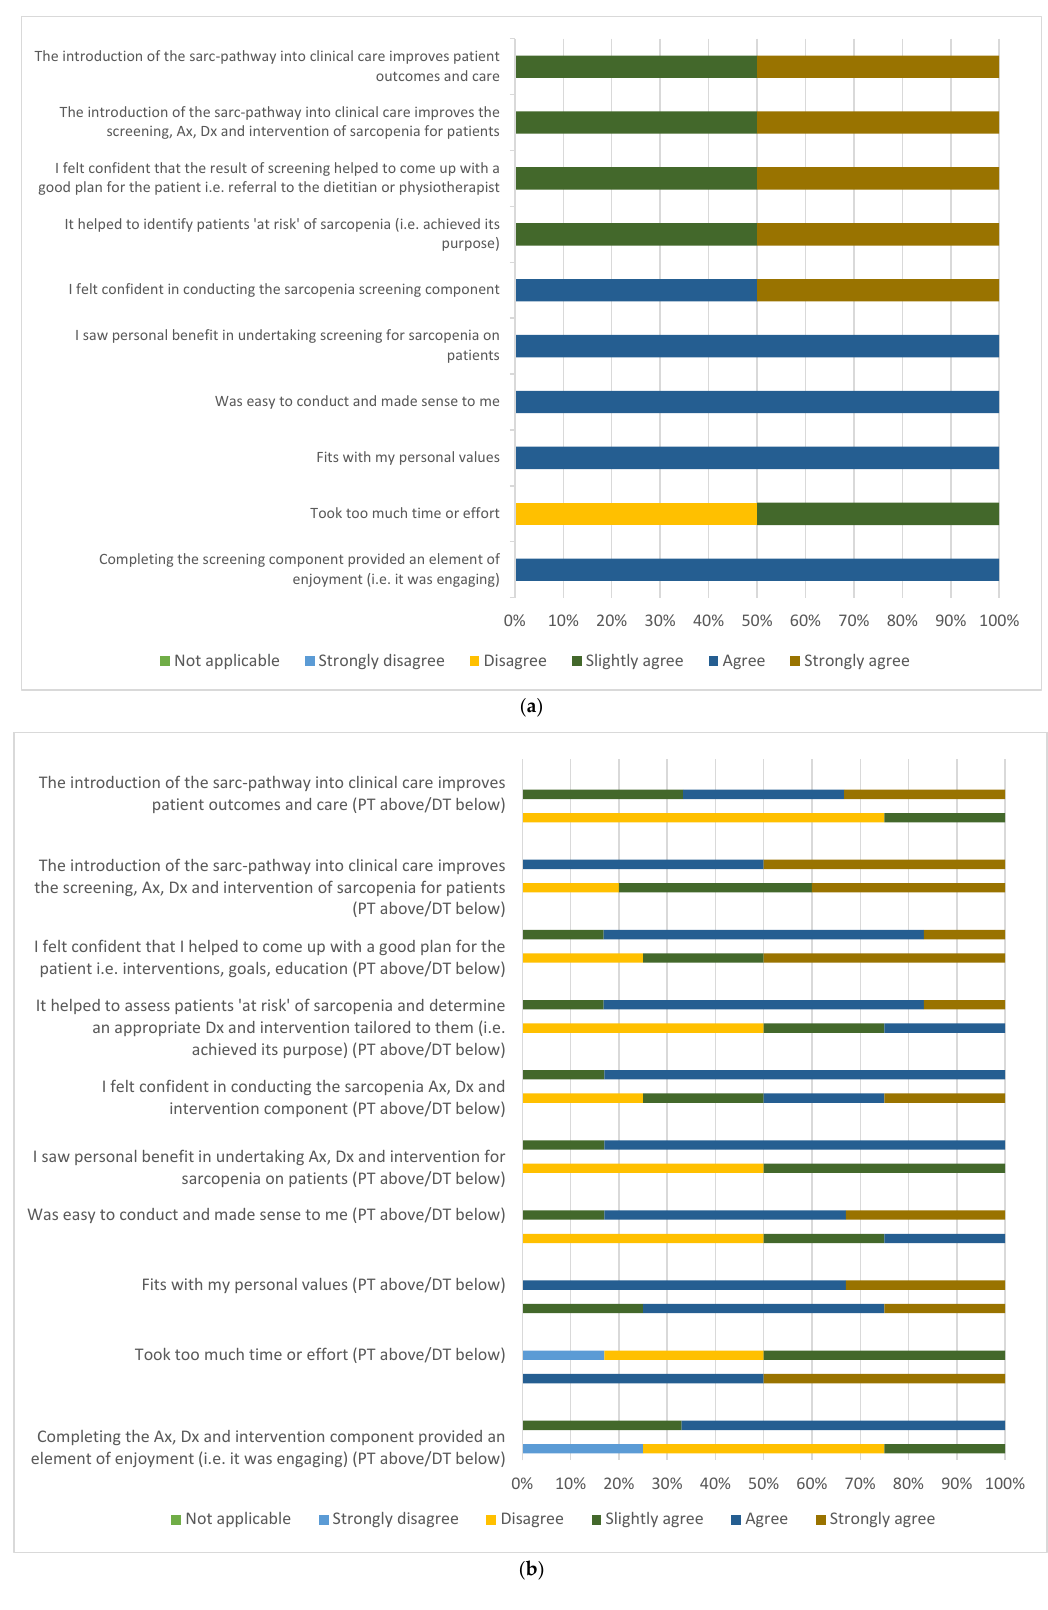
Figure 4. ( a ) Clinician (AHA-NA) acceptability of the sarc-pathway ( n = 2); ( b ) clinician (dietitian, n = 4 and physiotherapists/AHA-PT, n = 6) acceptability of the sarc-pathway. Abbreviations: Ax = assessment; Dx = diagnosis; DT = dietitian; PT = physiotherapist; AHA-PT = allied health assistant– physiotherapist.